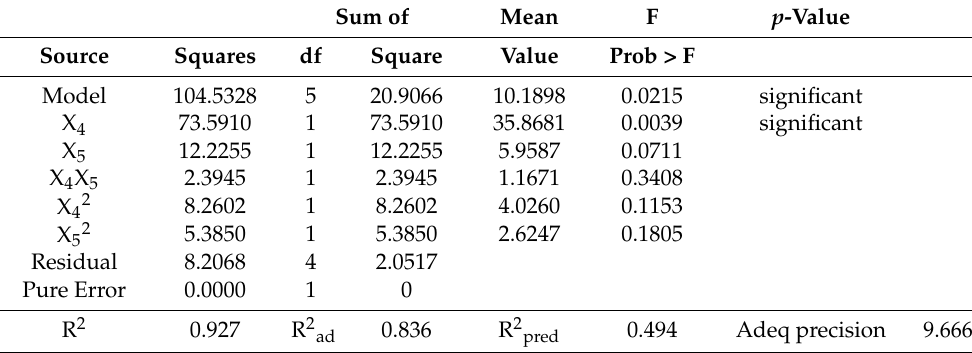
Table 6. ANOVA results for the response surface quadratic model on FLP process at 15 min. Sum